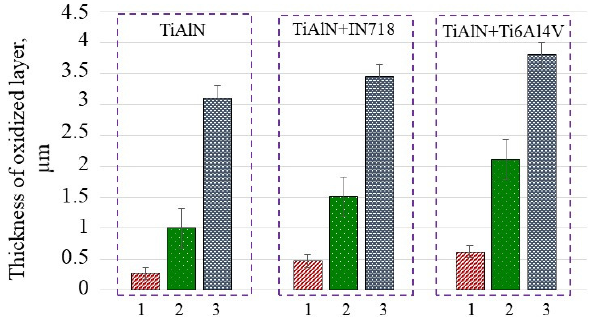
Figure 3. Increments of oxidized layer after annealing performed at 900 °C for 2.5 min (1); 10 min (2) and 30 min (3).